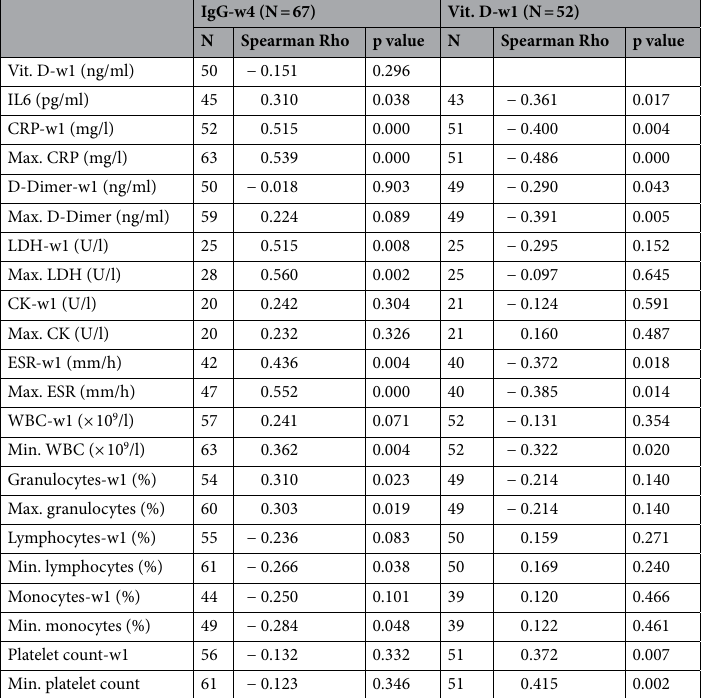
Table 2. Mutual correlation between IgG‑w4 and Vit. D‑w1 and correlation between these parameters and inflammatory and hematological markers. Spearman correlation and